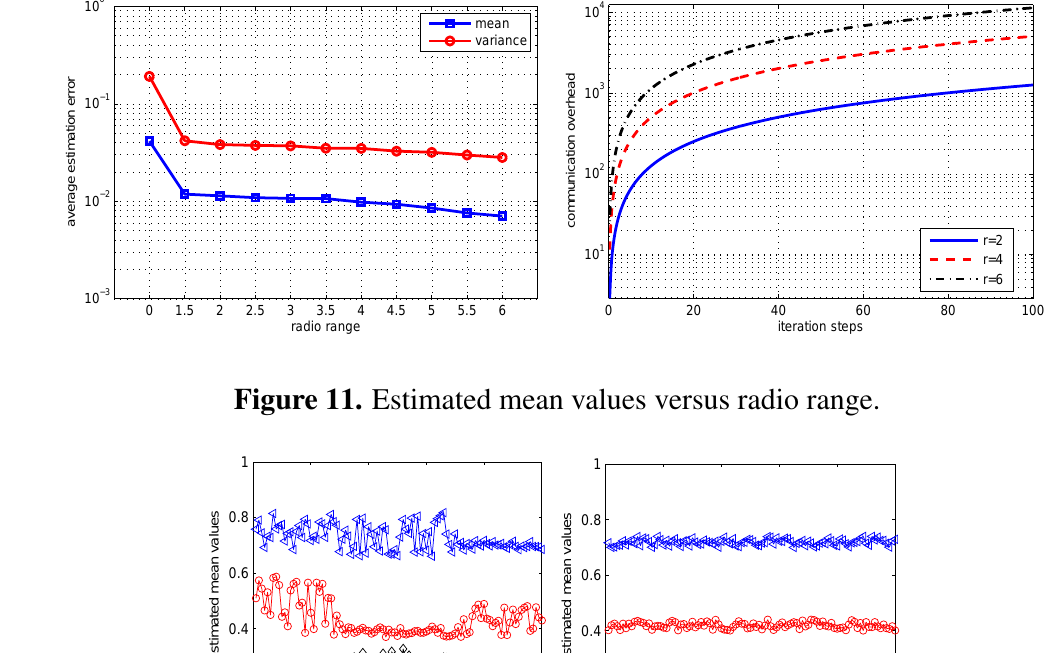
Figure 10. Estimation performance and communication overhead versus radio range.